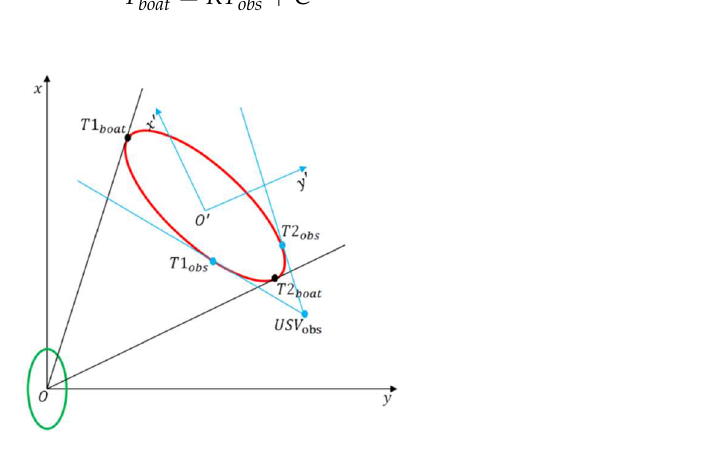
Figure 6. Ellipse tangents.